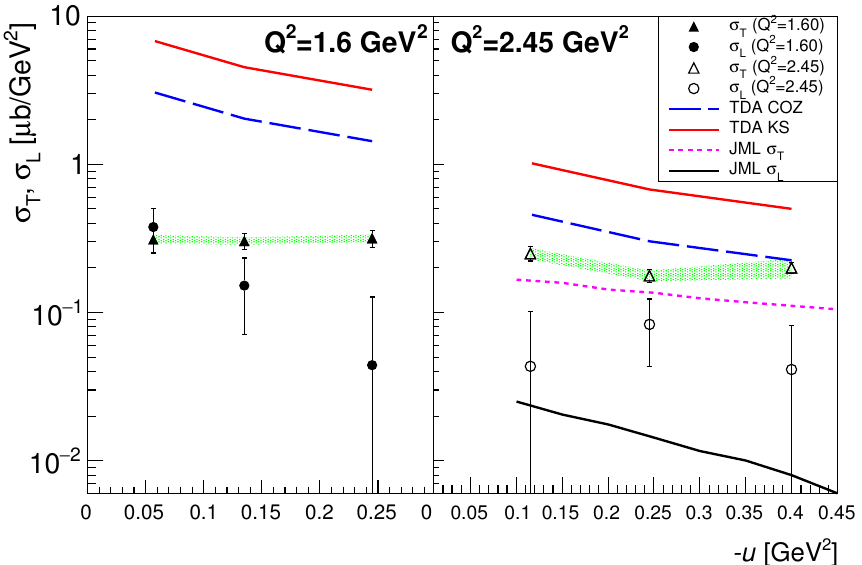
u , at Q 2 = 1.6 GeV 2 ( left ), 2.45 GeV 2 Figure 4. σ T (triangles), σ L (squares) as a function of − u bin, u (cid:48) = u u min ( right ). For the lowest 0. TDA predictions for σ T : COZ (blue dashed − − ≈ lines), KS (red solid lines). The predictions were calculated at the specific Q 2 , W values of each u bin (overline represents the nominal value), and the predictions at three u bins joined by straight lines for visualization purpose. Green bands indicate correlated systematic uncertainties for σ T , the uncertainties for σ L are similar. This plot was recreated from the data and model predictions published in Ref.